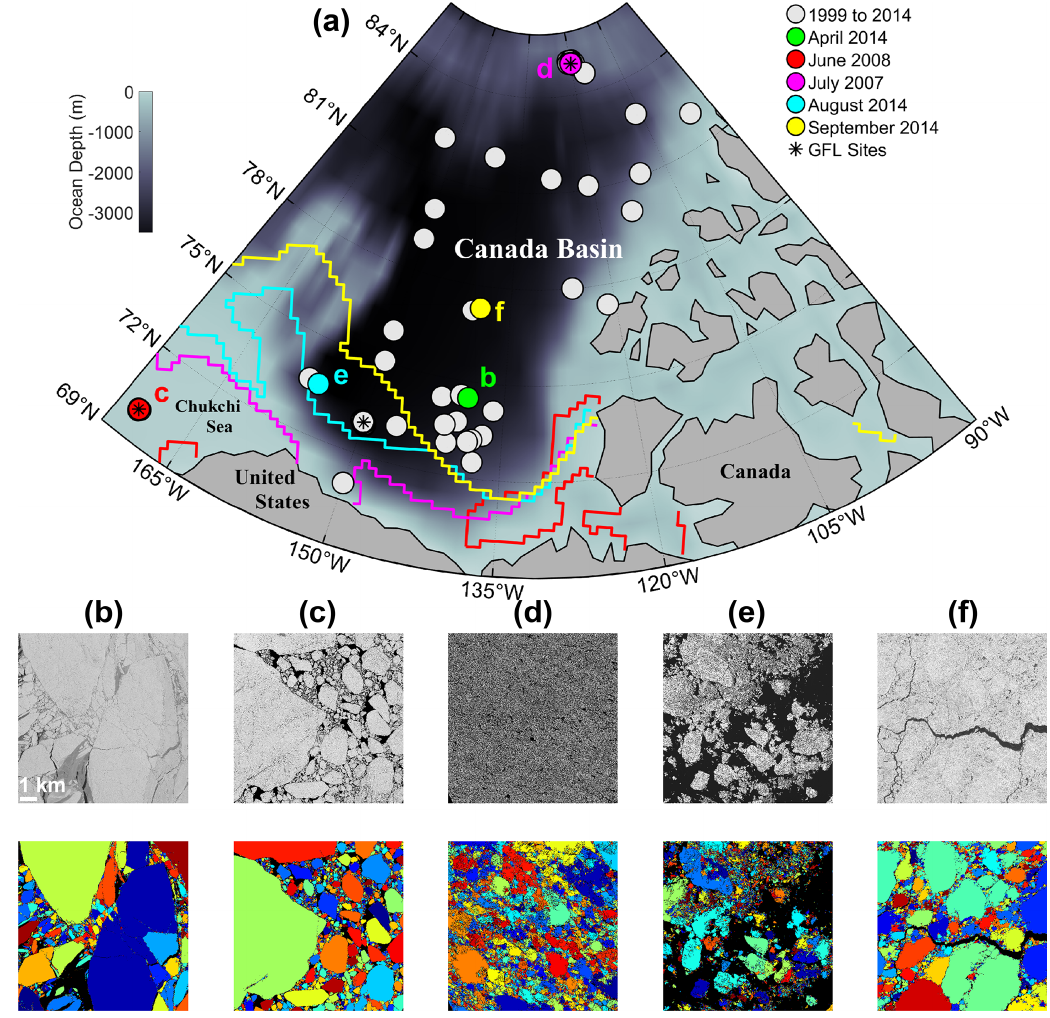
Figure 1. Map of study region with image locations, and example subsets of images and corresponding segmentations. (a) Study region within the Canada Basin with locations of 78 images from 1999 to 2014 (gray circles). (b) through (f) 100km 2 image subregions (top) and corresponding image segmentations (bottom) from (b) 30 April 2014, (c) 12 June 2008, (d) 23 July 2007, (e) 11 August 2014, and (f) 20 September 2014. Locations of images (b) (green)– (f) (yellow) are labeled on the map. USGS fiducial sites (black asterisks), for which there are images from multiple years, are noted to the southeast of (e) (Beaufort Sea), at (c) (Chukchi Sea), and at (d) (northern Canada Basin). Median ice extents (bounding the area with more than 15% concentration) are shown for (b) – (f) in corresponding colored lines for those months (the April 2014 extent is south of the map domain). The median monthly ice extents are from the NSIDC Sea Ice Index, Version 3 (Fetterer et al.,